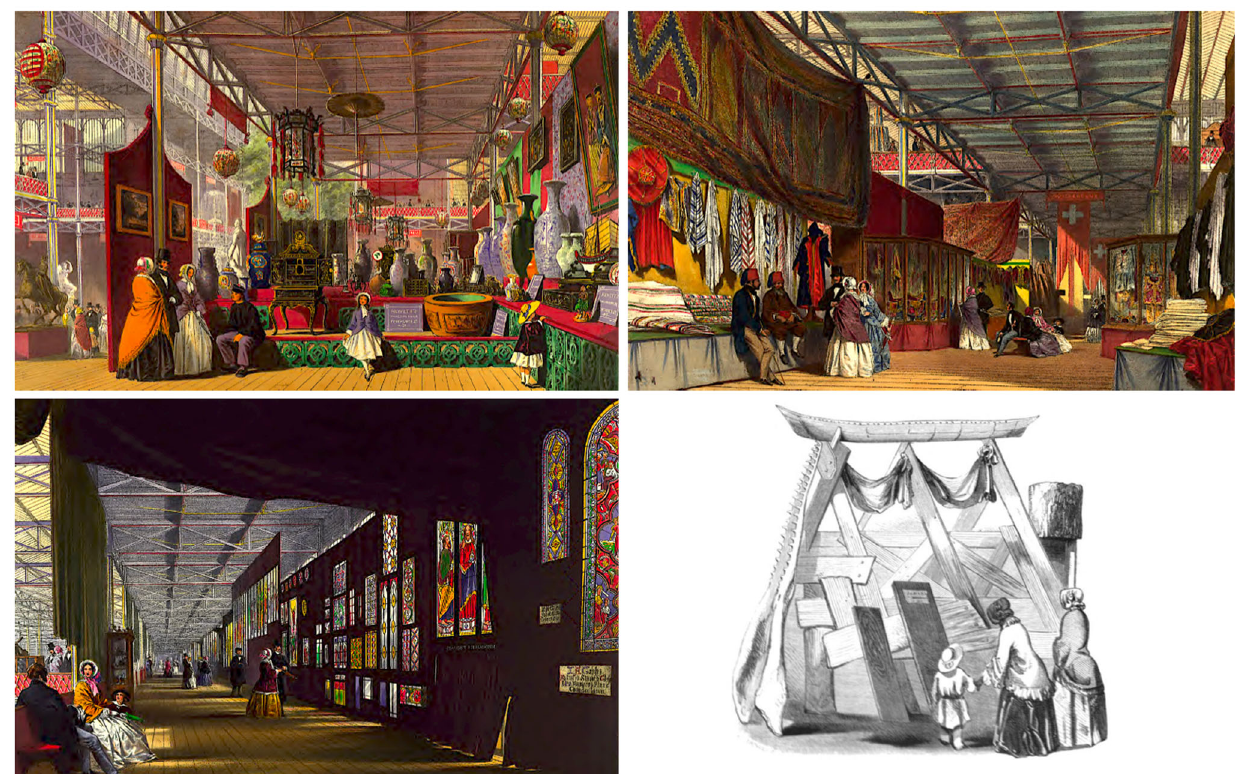
Fig. 1 Impressions from the 1851 Great London Exhibition. The Great Exhibition of 1851 brought together objects of art and industry from around the globe. Typical for the exhibition were the national as well as thematic sections. Making one ’ s way through them, one saw groups of similar-styled objects such as chinaware above left , stained glass below left , and textiles from Tunis above right . Even today, looking at the colorful illustrations that document the exhibition, one can recognize stylistic variants and diversity. For example, the Chinese vases all look quite similar; they are stylistic variants of each other. The same can be said about the stained glass windows. They also look alike, and they can also be taken to be stylistic variants of each other. However, the vases do not look much like the stained glass and vice versa. The difference between vases and stained glass is what we may call stylistic diversity.